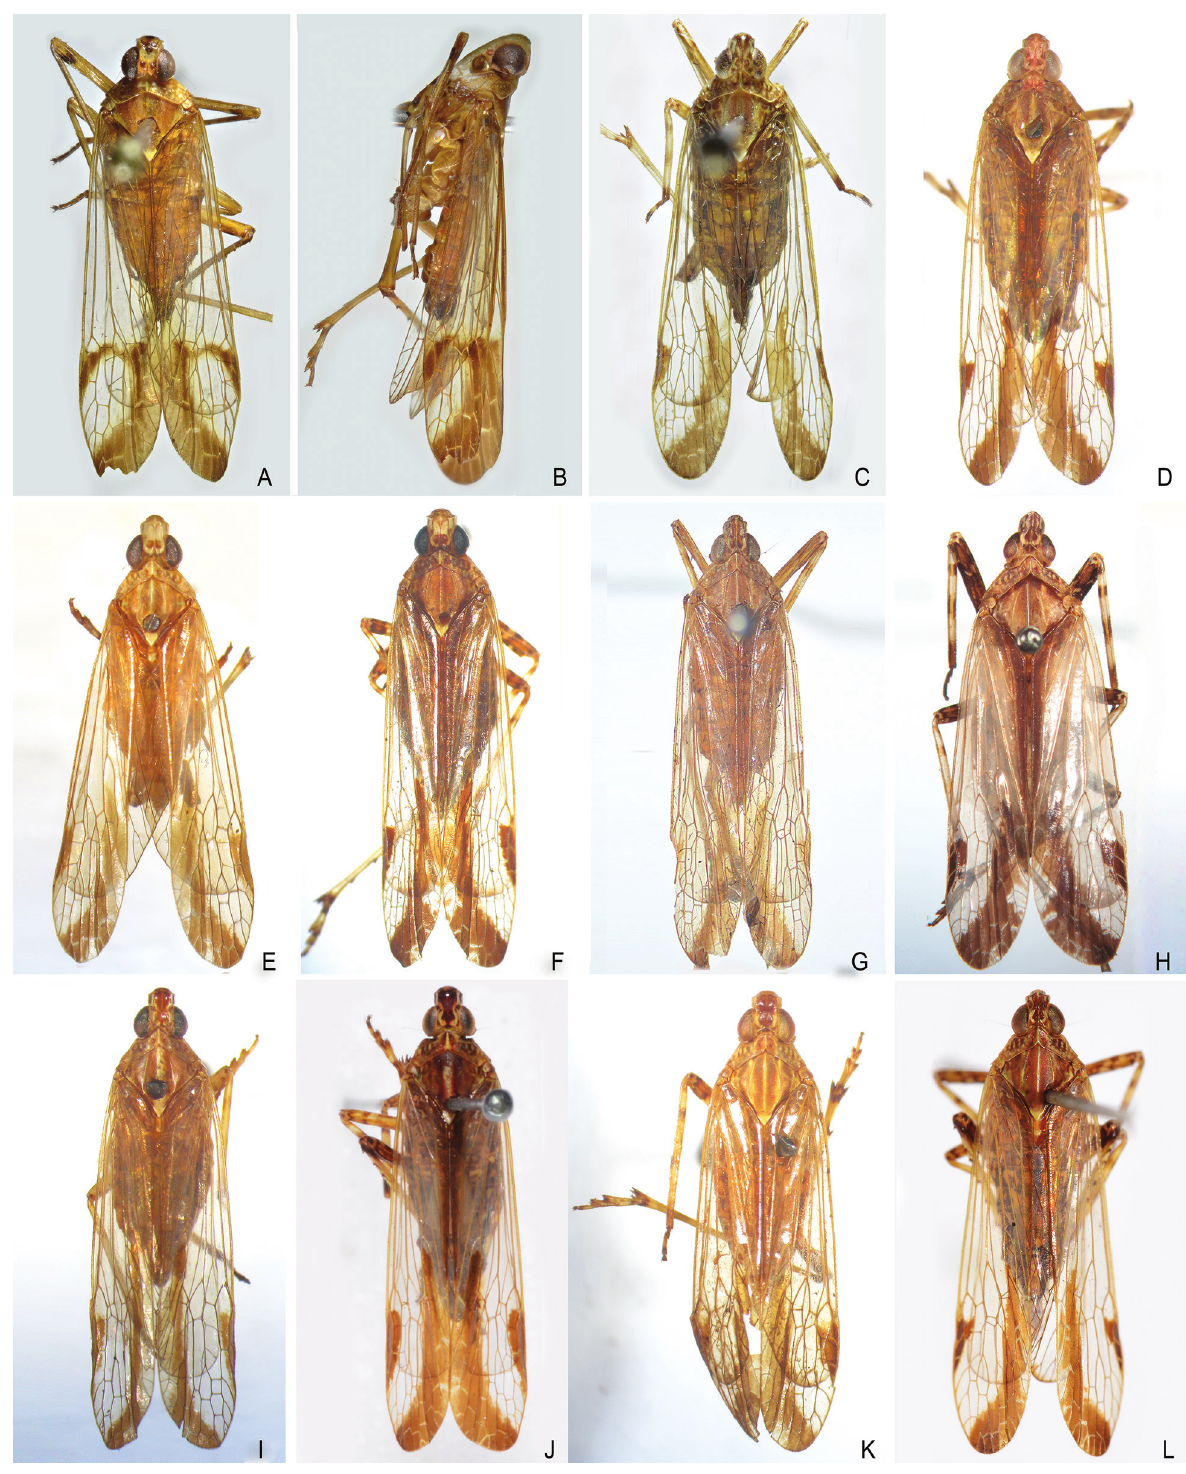
Figure 2. Habitus of Orthopagus species. ( A, B ) O. bartletti sp. n., male, holotype, Karnataka, India; ( C, D ) O. exoletus (Meli- char), male and female, Sri Lanka; ( E, F ) O. hainanensis sp. n., male and female, paratypes, Hainan, China; ( G, H ) O. lunulifer Uhler, male and female, China; ( I, J ) O. philippinus Melichar, male and female, Philippines; ( K, L ) O. splendens (Germar), male and female,